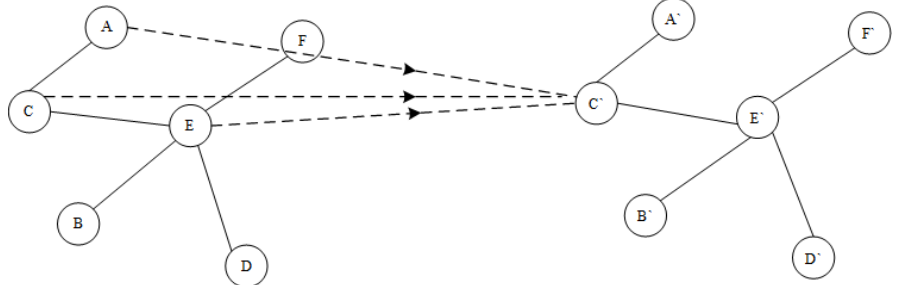
Figure 6. GCN local convolution